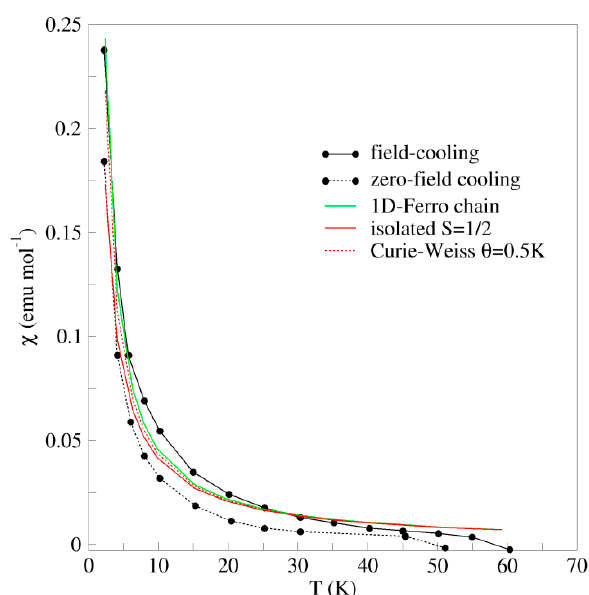
Figure 7. Temperature dependence of the magnetic susceptibility of [n-Bu 4 N] 2 [Cu(dmit) 2 ] at low temperature. The experimental data (field-cooling and zero-field cooling) are adapted from Ref. [23]. Green curve corresponds to the 1D-ferromagnetic S = 1/2 chain [48], with g = 2.09 and J = 0.7 cm − 1 . Red curves represent the Curie law for the isolated S = 1/2 magnetic units (solid line) and the Curie–Weiss law with ferromagnetic Weiss constant θ = 0.5 K (dotted red line) (g = 2.09).